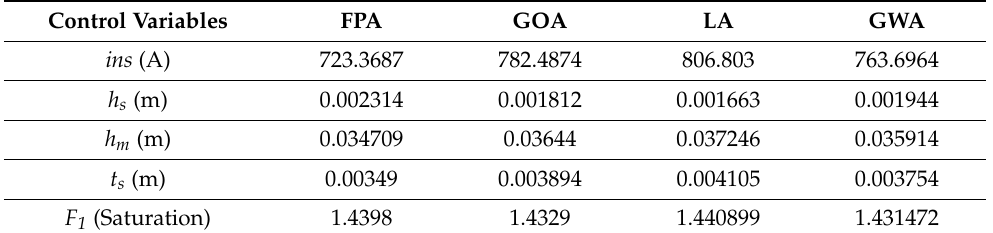
Table 1. Optimal results of the GWA, FPA, LA, and GOA for TLSM design under first case.